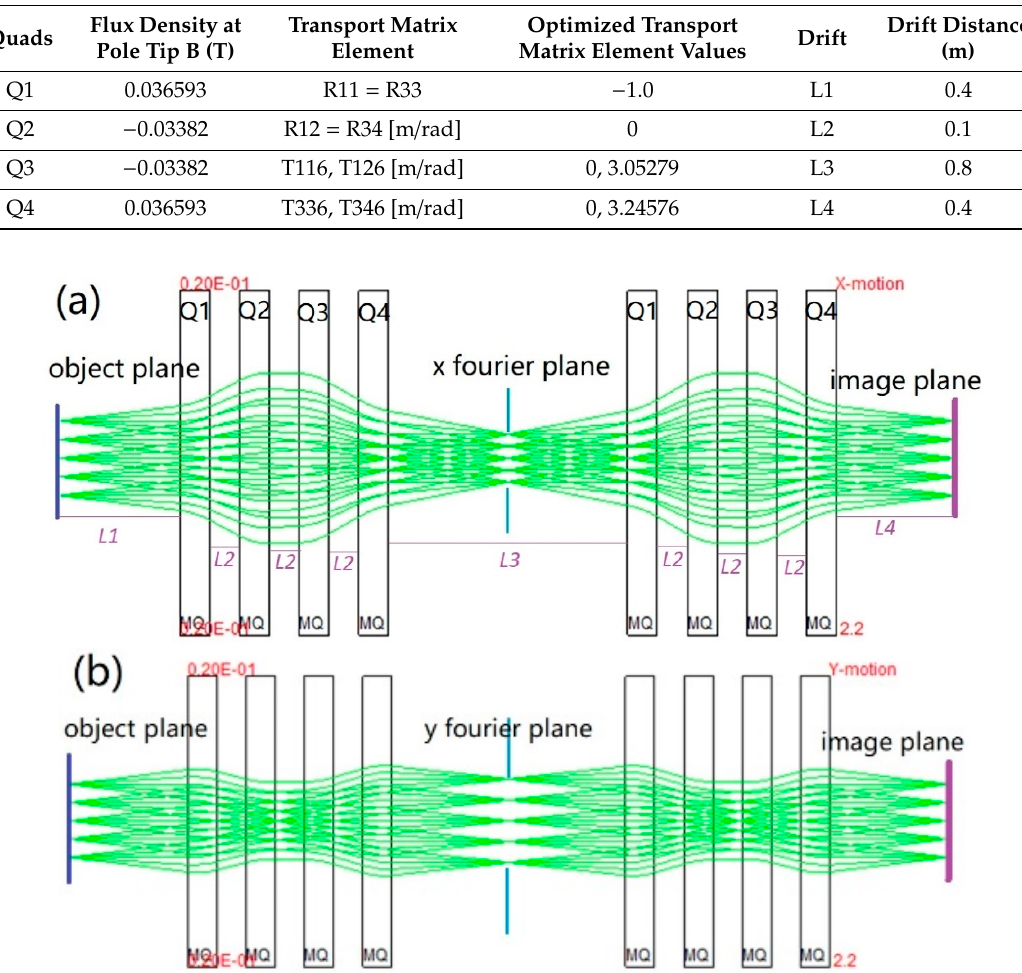
Figure 2. Electron beam trajectories from the object plane to image plane through the imaging lens in the ( a ) x plane and ( b ) y plane.